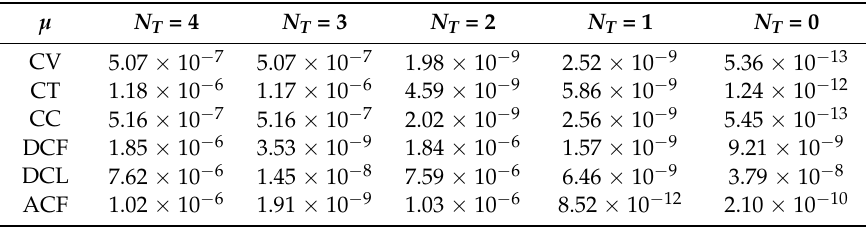
Table 5. Sensitivity analysis of repair parameters to state